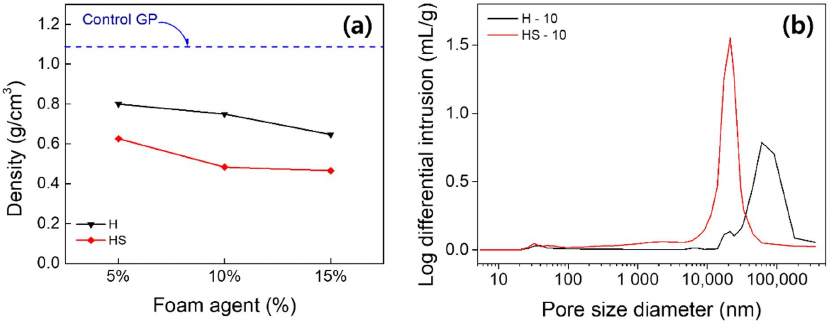
Figure 5. ( a ) Density of GP foam with varying activator content, and ( b ) local differential intrusion of mercury (i.e., net density of mercury) for pore sizes of H -10 and HS -10 ( H + SDS).